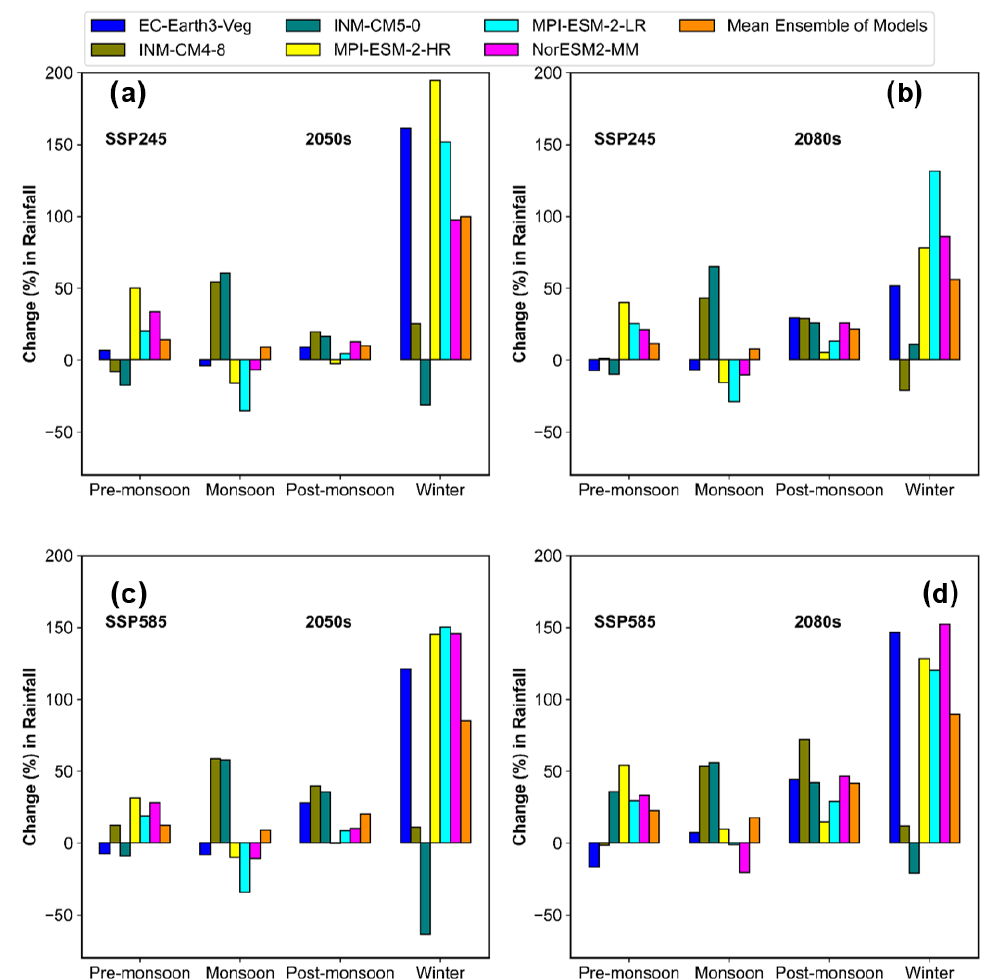
Figure 12. Projected change in the mean seasonal rainfall in the sub-basin using different CMIP6 GCMs under the SSP245 and SSP585 scenarios in the (a, c) 2050s and (b, d)